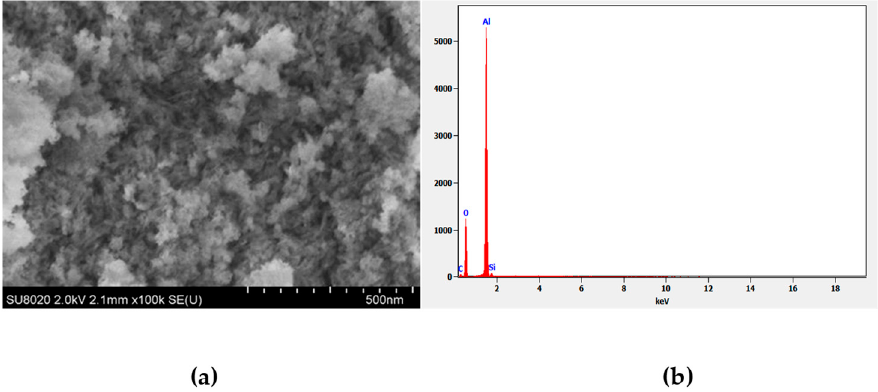
Figure 2. ( a ) Scanning electron microscope (SEM) image; ( b ) EDX spectrum.